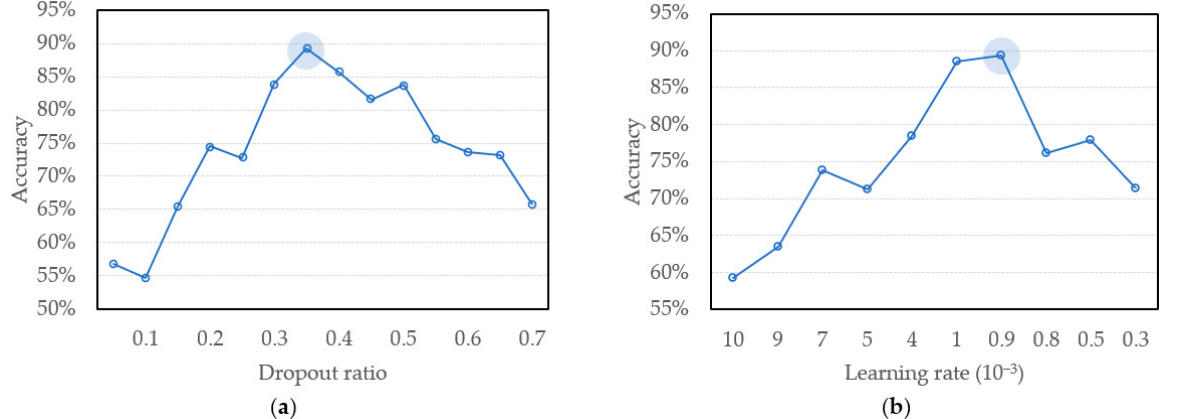
Figure 8. Accuracy of the best model in different hyperparameters from GridSearchCV ( a ) dropout ratio ( b ) learning rate.